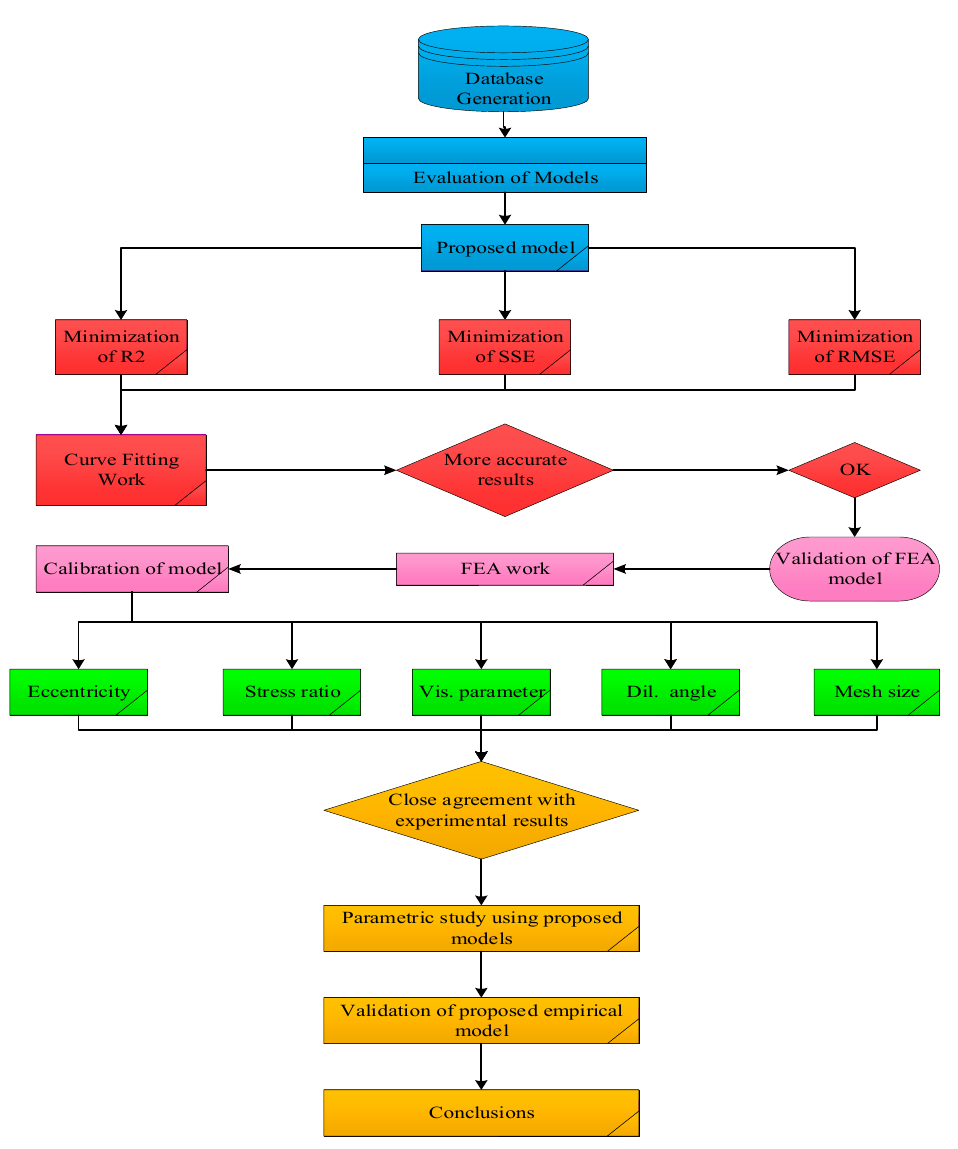
Figure 1. Flow chart of the present work.